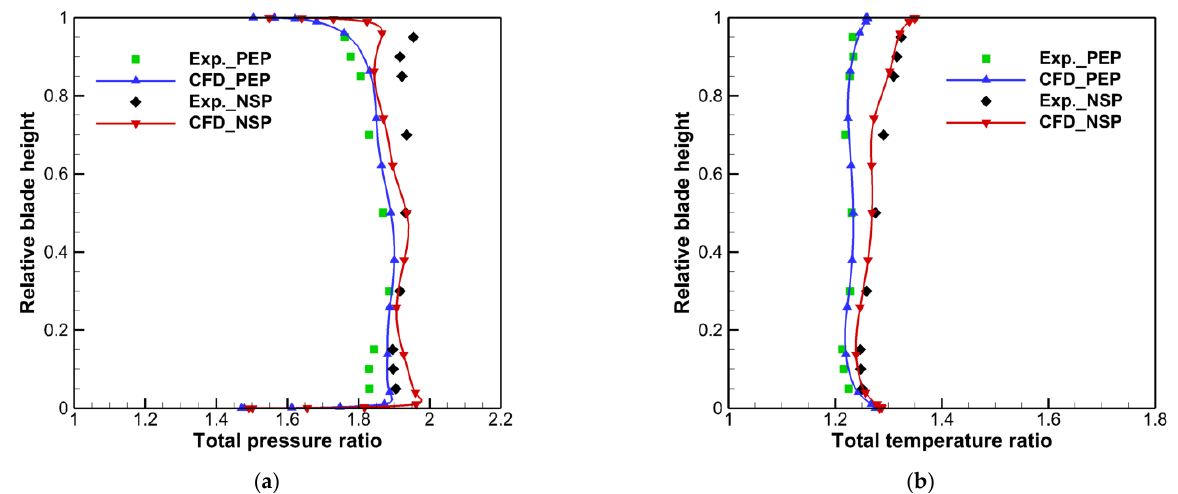
Figure 5. Spanwise distribution comparison of outlet parameters at the PEP and NSP: ( a ) Total pressure ratio ; ( b ) Total temperature ratio .